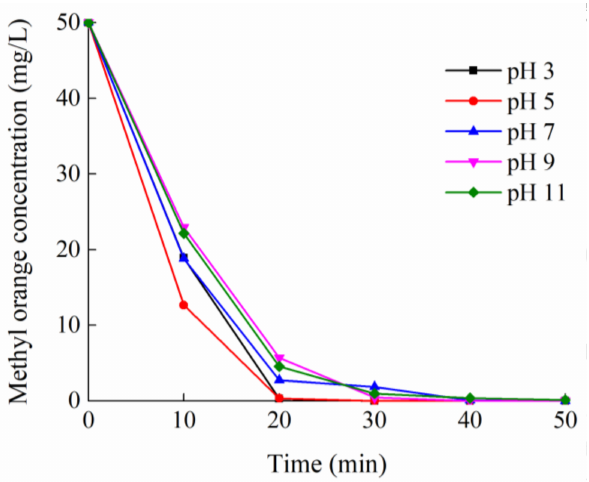
Figure 3. Effects of pH on the treatment of methyl orange by ozone